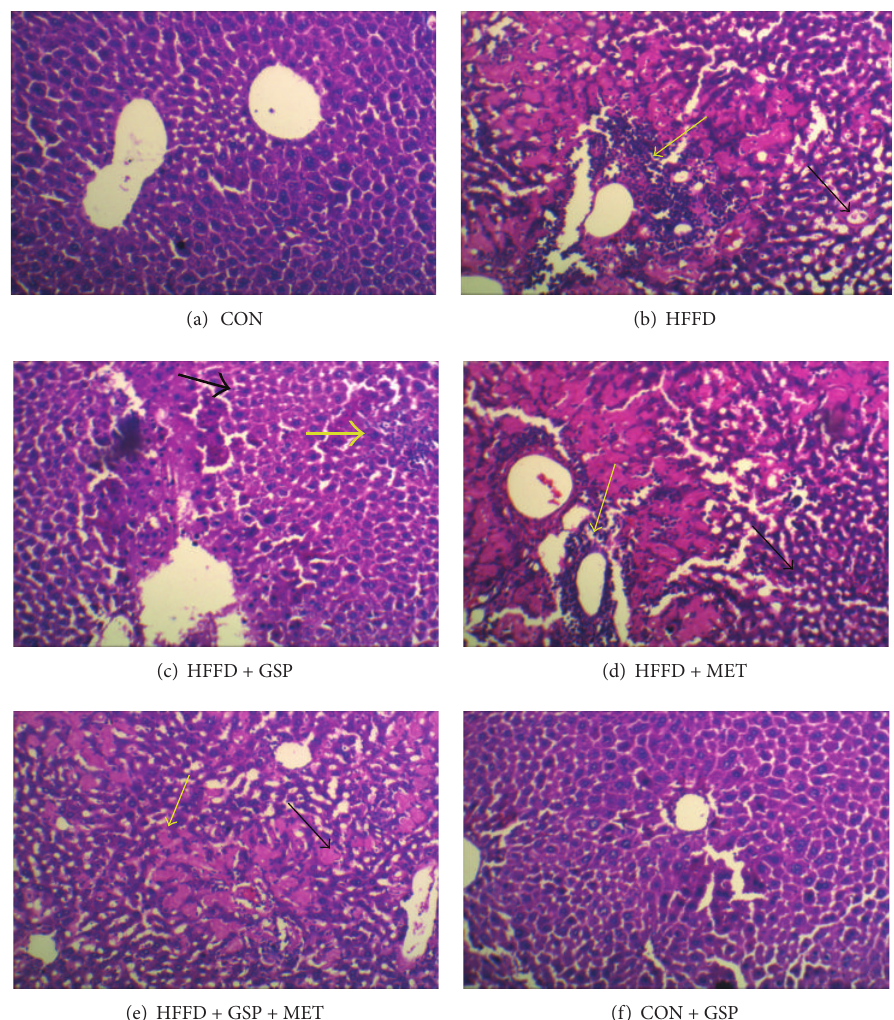
Figure 8: Histology of liver stained using hematoxylin and eosin. Section from control liver (a) and CON + GSP (f) shows hepatocytes within normal architecture arranged in the lobules around the central vein. Liver of HFFD-fed rats (b) shows severe micro- and macrovesicular changes and dense perivascular inflammatory infiltrate. HFFD + GSP show minimal inflammatory infiltrate with mild steatosis (c). Liver section from HFFD + MET (d) shows moderate amount of inflammatory infiltrate with microvesicular degeneration of hepatocytes. Section from the liver of HFFD + GSP + MET (e) shows hepatocytes with marked reduction of inflammation and steatosis. (Black arrows indicate steatosis and the yellow arrows indicate